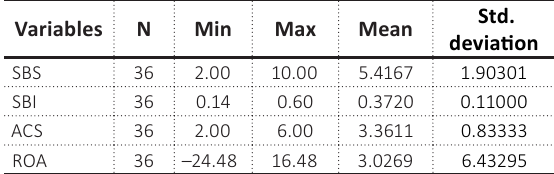
Table 3. Descriptive statistics of SBS , SBI , ACS , and ROA